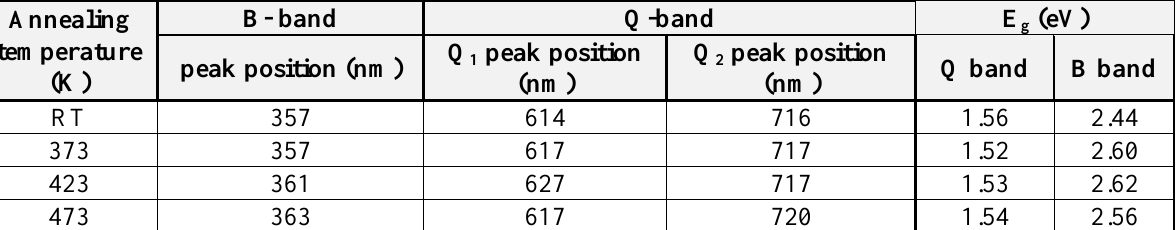
Table 5: Bands position and optical energy gaps of CuPcTs/PEDOT PSS thin films at different annealing temperatures.